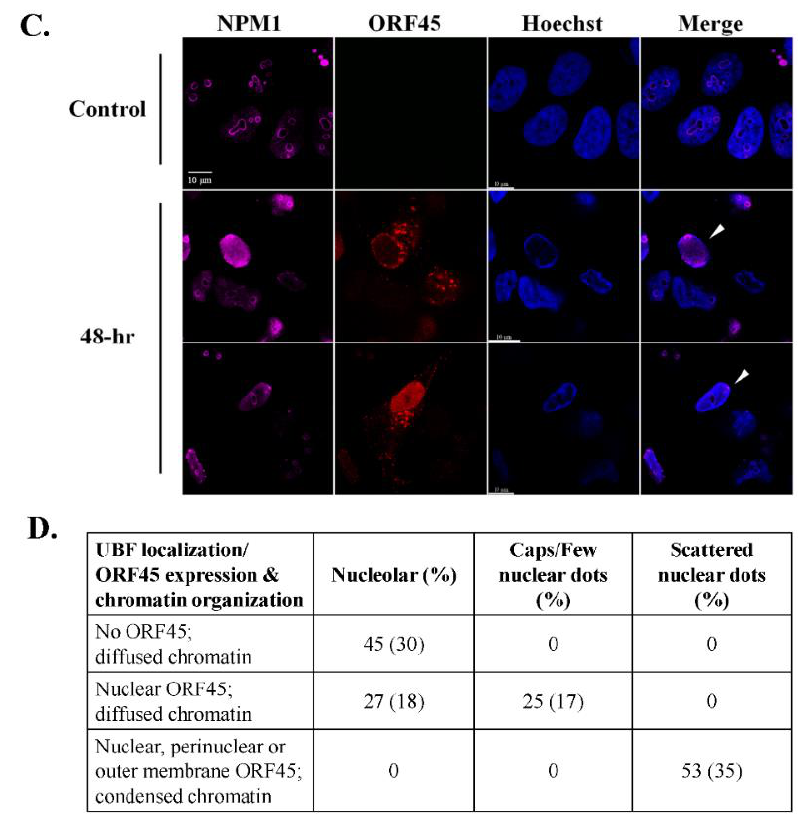
Figure 1. Redistribution of the nucleolar proteins UBF, Fibrillarin and Nucleophosmin 1 (NPM1) upon lytic reactivation of KSHV in iSLK-infected cells. BAC16-mCherry-ORF45-infected iSLK cells were treated for 48 h with 1 µ g/mL Dox and 1 mM n-Butyrate to induce viral lytic reactivation. Uninduced infected iSLK cells were used as controls. Cells were stained with antibodies to UBF or ( A ), Fibrillarin followed by anti-rabbit Alexa Fluor 647-conjugated secondary antibody ( B ) or NPM1 followed by anti-mouse Alexa Fluor 647-conjugated antibodies ( C ). The corresponding staining of nuclear DNA by Hoechst is also shown. mCherry-ORF45 expression and localization and the appearance of condensed chromatin staining marked different stages of cells undergoing viral lytic reactivation. Arrows indicate different patterns of redistribution. Right-hand columns show the merged output of the nucleolar proteins immunofluorescence and Hoechst staining 150 cells were scored according to the cellular distribution of UBF along with ORF45 expression and localization and chromatin organization ( D